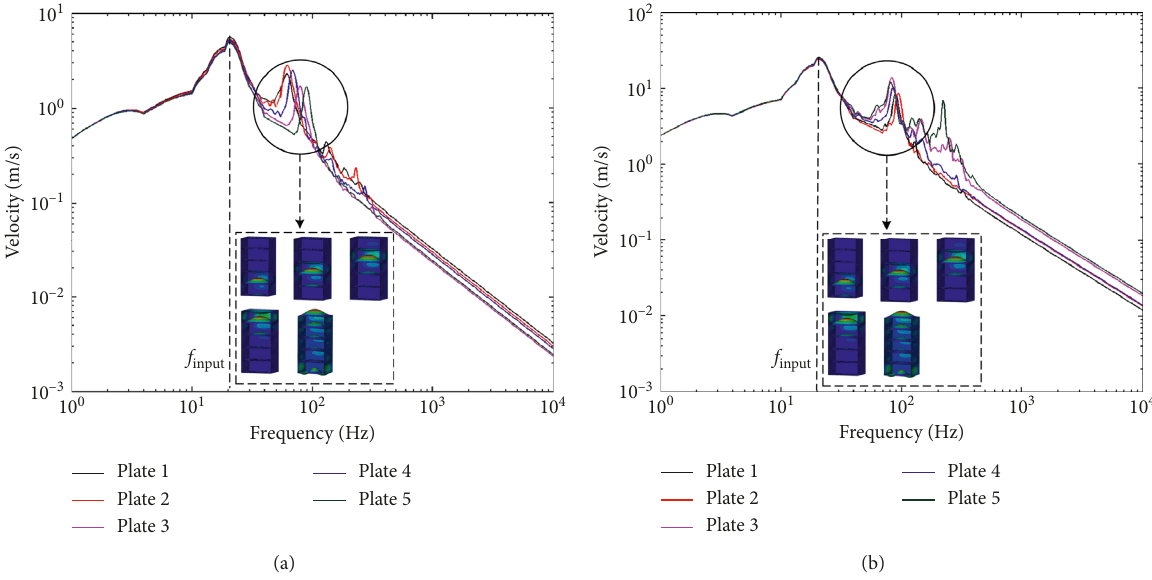
Figure 12: Shock spectrums of five plates when frequency of load is 20Hz. (a) Load with low amplitude. (b) Load with high